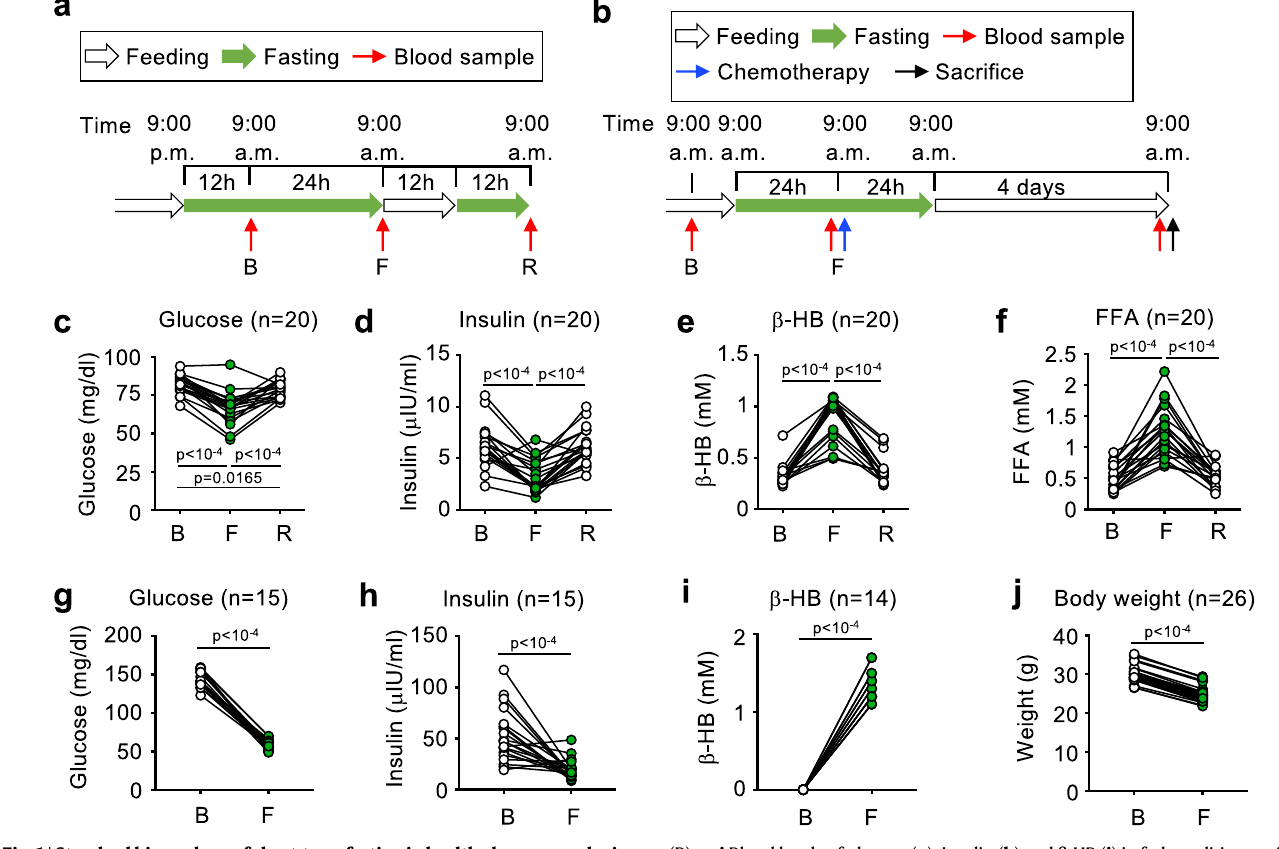
(R). g – i Bloodlevels ofglucose( g ),insulin( h ) and β -HB( i )infed conditions at fi rst time in the morning (Basal, B) and after 24h of fasting (F). j Mouse body weight at the indicated times. Each dot represents the data from a single individual, and